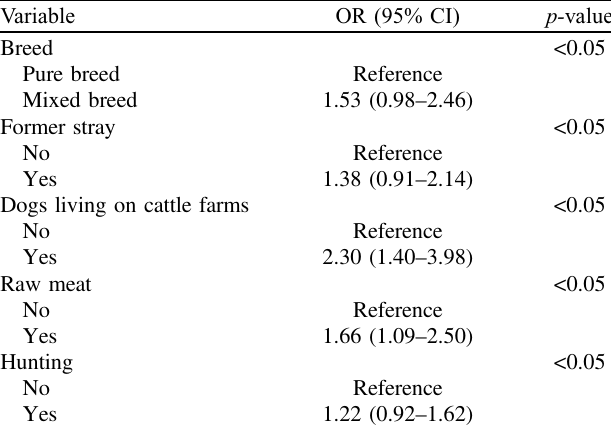
Table 2. Odds-ratios (OR) with 95% con fi dence interval and p - values based on likelihood ratio tests for variables associated with Neospora caninum seropositivity in dogs in multivariable logistic regression